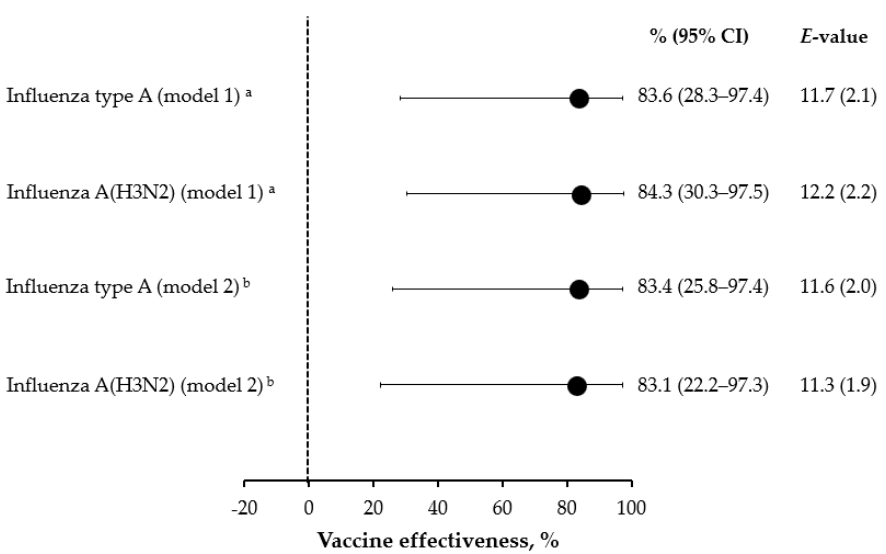
Table 2. Comparison of cases and controls.